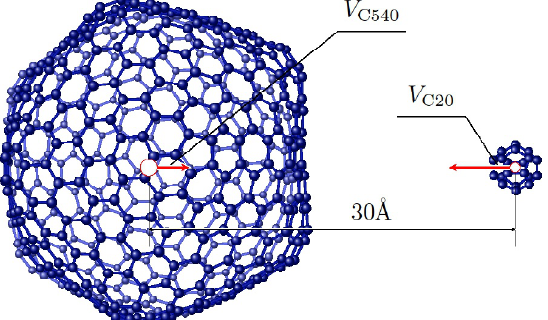
Fig. 1. The initial state: two equilibrium fullerenes C and C are the initial distance of 30 Å between 540 20 their centers of mass moving toward each other with the velocities V =- V /27 so that the center of C540 C20 mass of the whole system is at